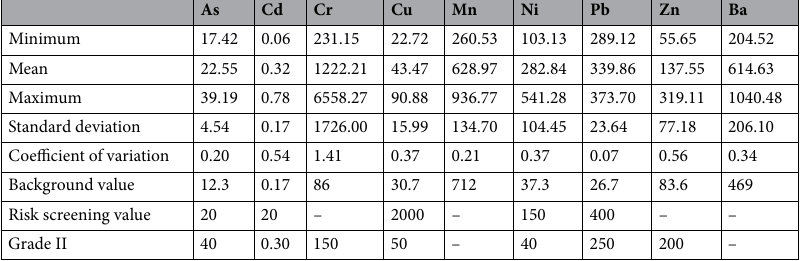
Table 1. Statistical characteristics for potential toxic elements in in the study area (mg·kg −1